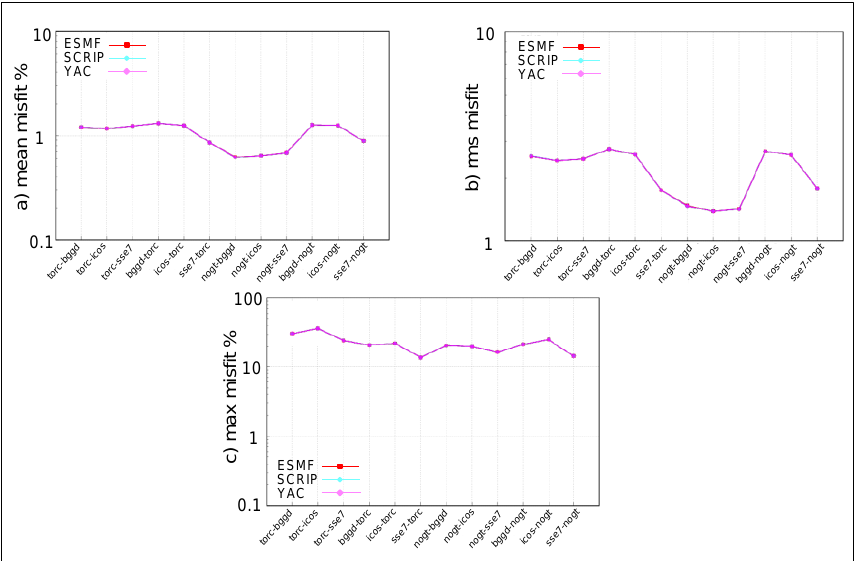
Figure 3. ( a ) mean, ( b ) rms and ( c ) maximum misfit for the different pairs of grids for the harmonic function for nearest neighbour algorithm for ESMF, SCRIP and YAC.